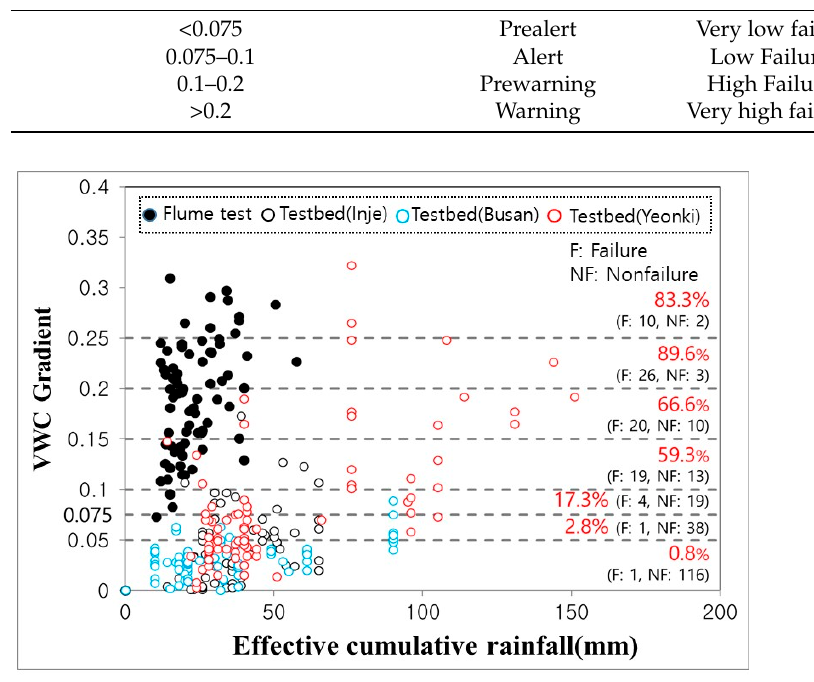
Figure 10. Rate of landslide occurrence according to the VWC gradient.